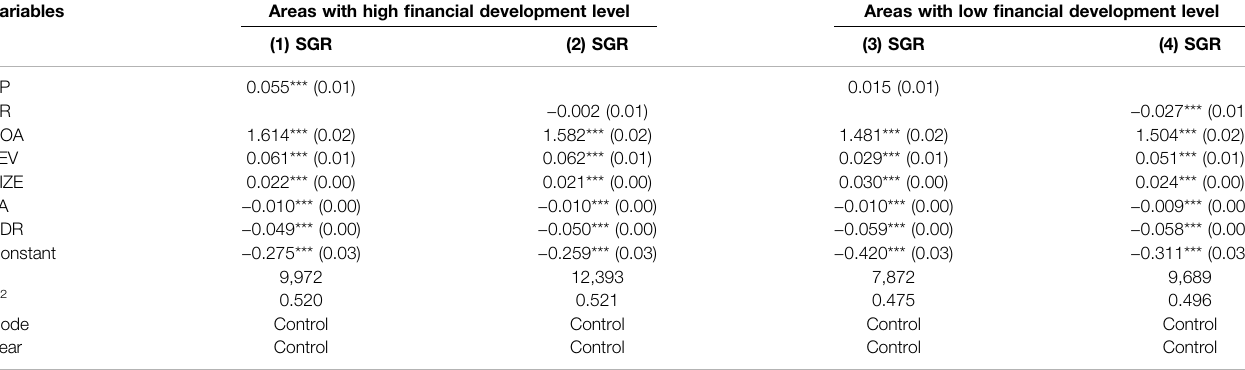
TABLE 5 | Heterogeneity analysis: Level of fi nancial development.